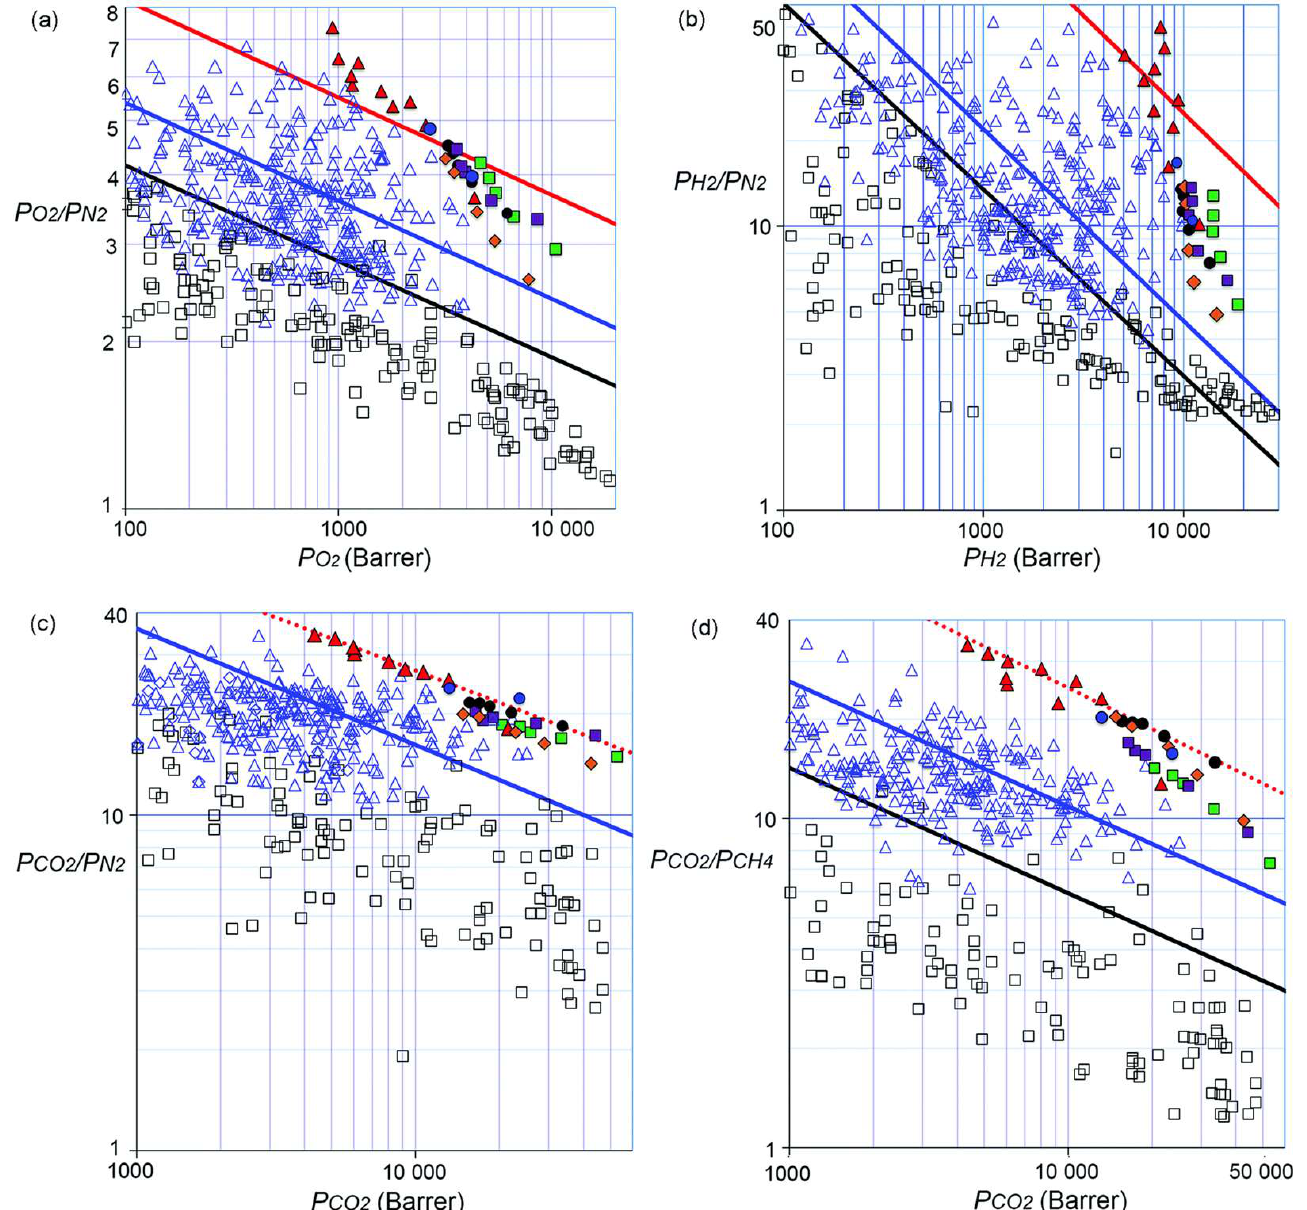
Figure 1. Robeson plots for the ( a ) O 2 /N 2 , ( b ) H 2 /N 2 , ( c ) CO 2 /N 2 , and ( d ) CO 2 /CH 4 gas pairs. Upper bounds are represented by black lines (1991) and blue lines (2008). Red lines represent revisions proposed in 2015 (solid) and 2019 (dotted). Black squares are non-PIM materials, and blue triangles represent PIMs. Filled symbols represent newly synthesized ultra-permeable benzotriptycene-based PIMs. Figure reproduced from [73] under CC-BY license terms.